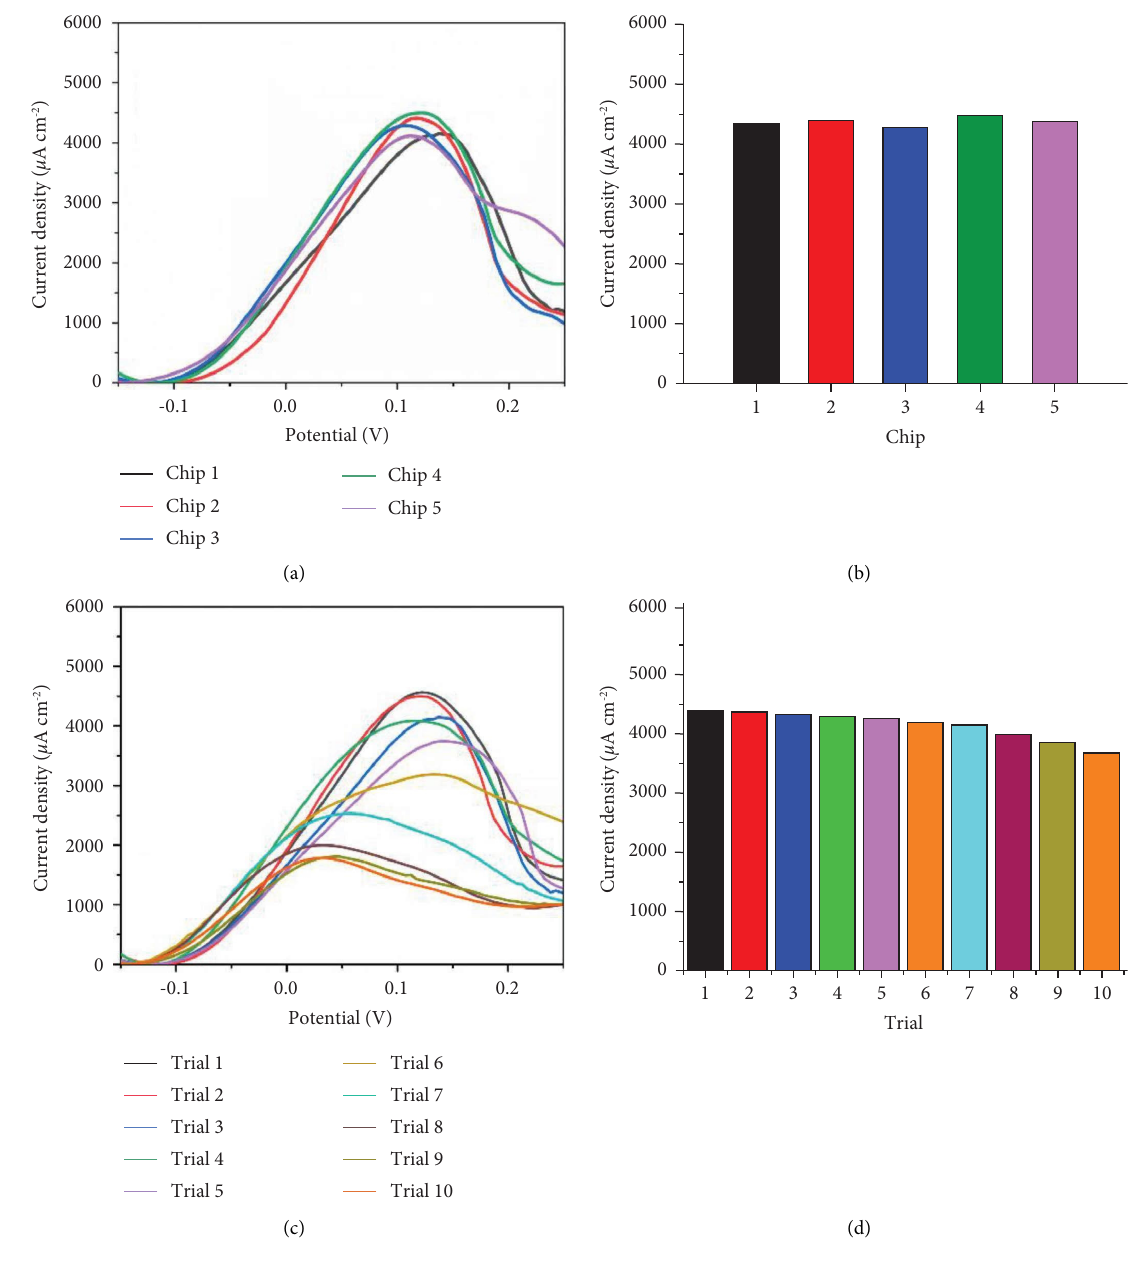
Figure 4: SWASV responses of (a) fve MnO 2 /SP-modifed SPEs chips and (b) the relevant current density of the anodic stripping peaks. (c) SWASV responses of a MnO 2 /SP-modifed SPEs chip measured repeatedly for 10 times, and (d) relevant current density of the anodic stripping peaks. Te test solution: 0.1 M NaAc-HAc (pH 5.0) + 10 nM Cu 2+